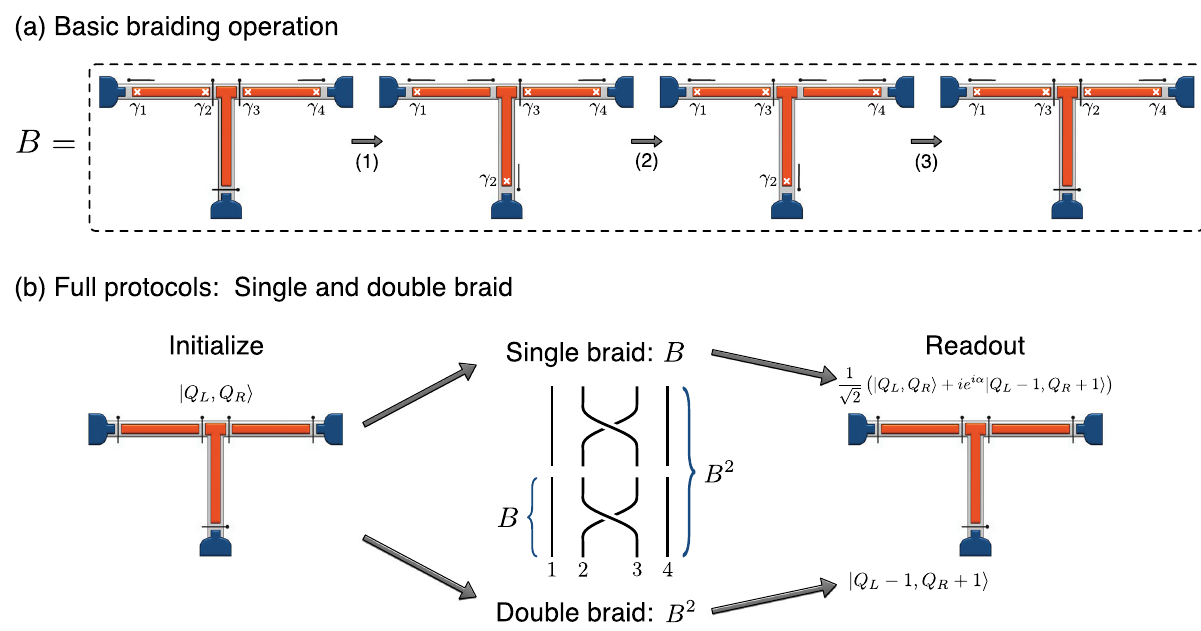
FIG. 11. (a) Elementary braid of Majorana zero modes in a trijunction hosting a single topological qubit. Modulating the three valves adjacent to the vertical island controls both charging effects and the coupling between neighboring topological superconductors. Steps (1) – (3) use this flexibility to braid the inner Majorana modes γ 2 and γ 3 , thus nontrivially rotating the topological qubit via the non- Abelian braid matrix in Eq. (35). (b) Experimental protocols for verifying “ rigid ” qubit rotation induced by braiding. Beginning from the ground state of decoupled, charging-energy-dominated islands, the topological qubit is initialized into the j 0 i state by opening the outer valves. A single braid (upper path) or double braid (lower path) rotates the topological qubit, and then charging energy is restored for read out. Under the single braid the qubit rotates into an equal superposition of j 0 i and j 1 i leading to maximally uncertain measurement outcome; the double braid flips the qubit to j 1 i and returns a unique measurement